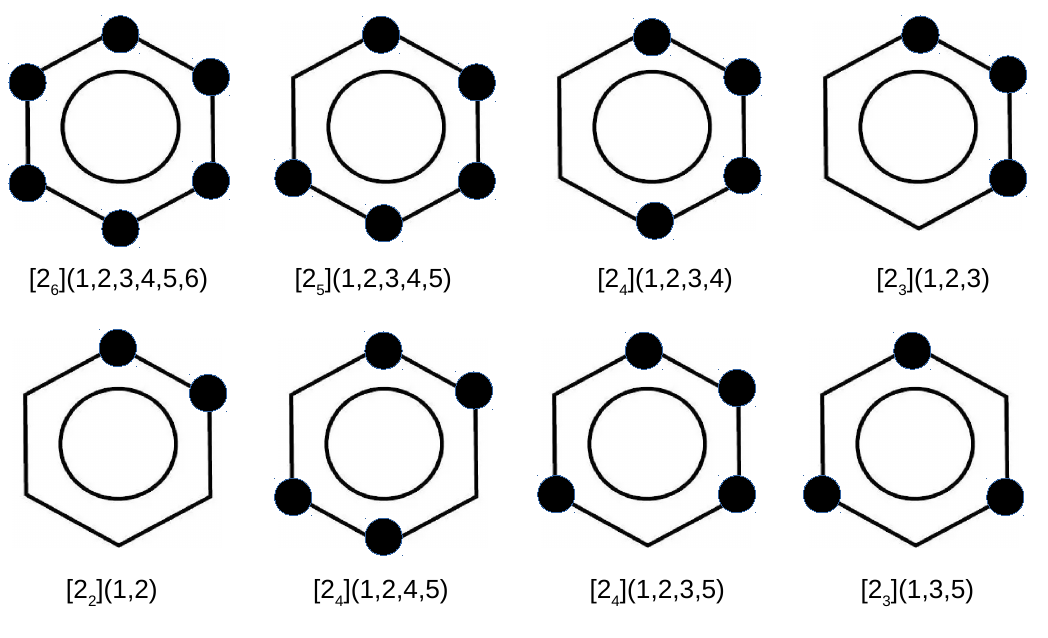
Figure 3. Considered cyclophanes. Large dots indicate the presence of ethylene bridges linking two benzene rings of the cyclophane molecule.